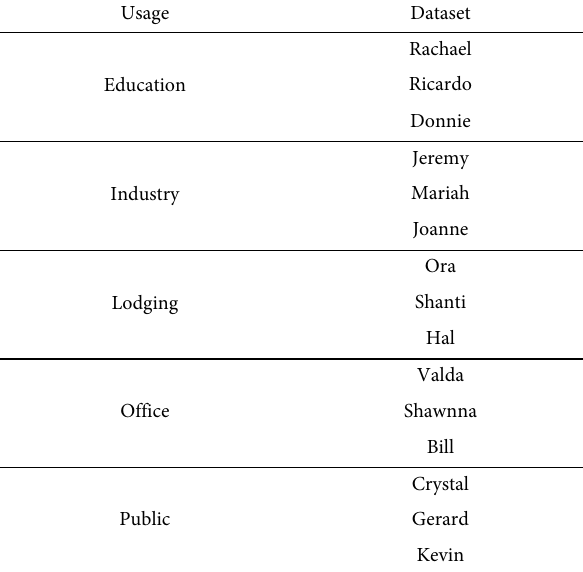
Table 1 The selected datasets in the USA